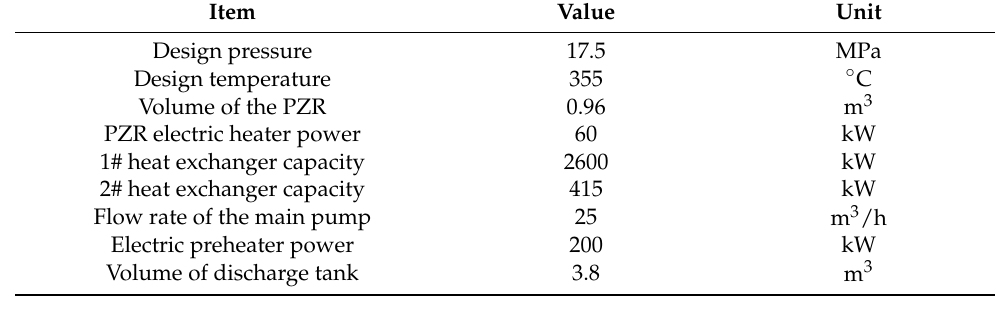
Table 3. Design parameters of the high pressure water loop.